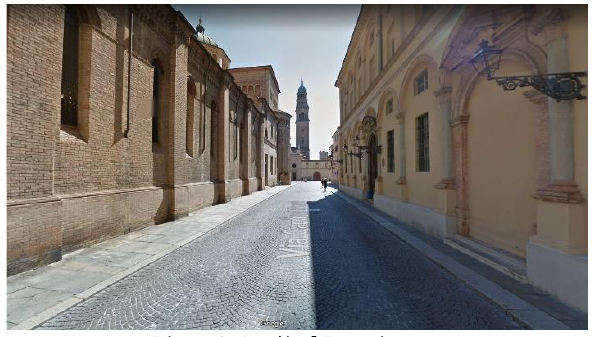
Figure 8. Cardinal Ferrari street.